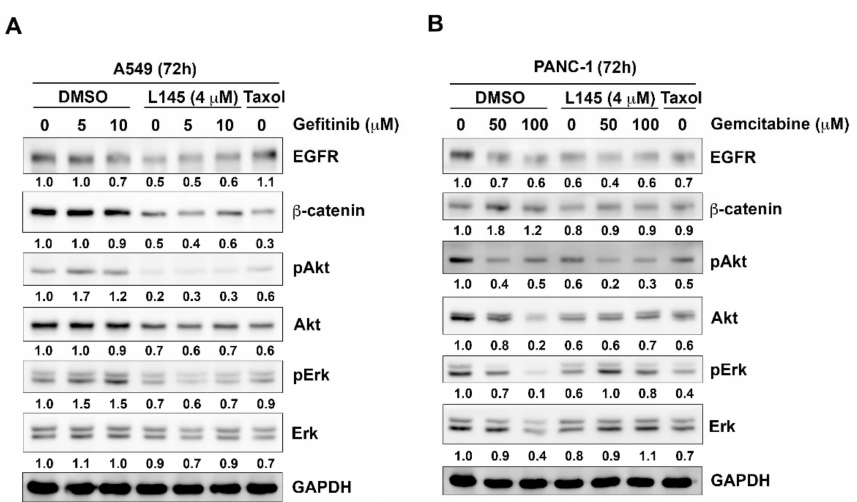
Figure 5. E ff ects of drug combination on cell survival pathways in cancer cells. ( A ) A549 and ( B ) PANC-1 cells were treated with MPT0L145 (L145, 4 µ M) in combination with gefitinib or gemcitabine, respectively for 72h. The cells were then subjected to western blot